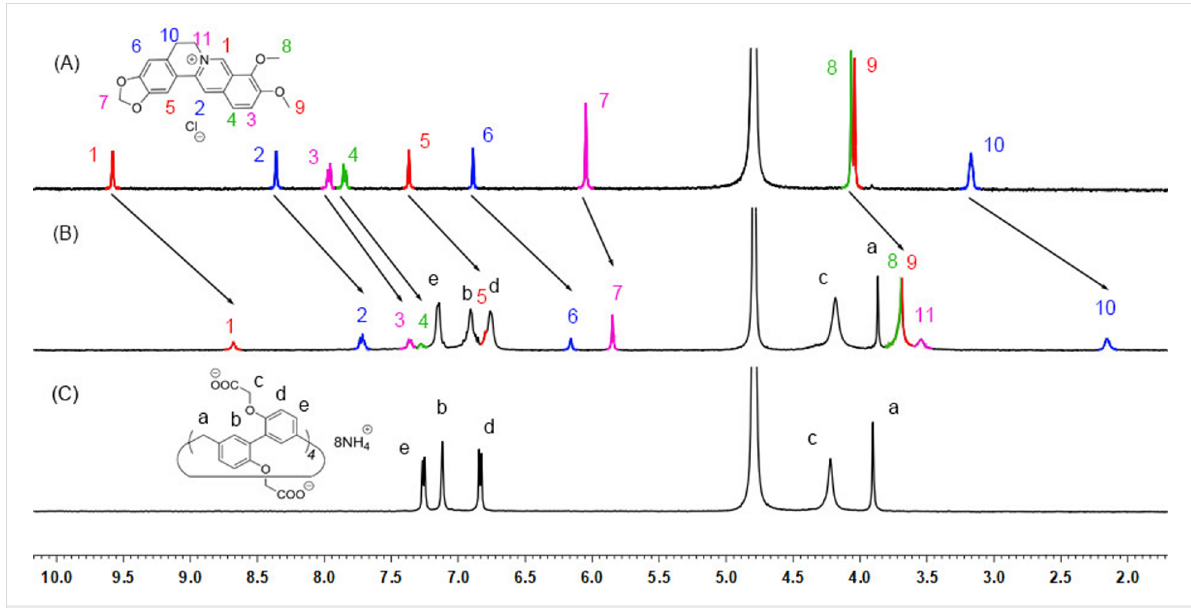
Figure 1: 1 H NMR spectra (500 MHz, 293 K) of (A) B (2.0 mM), (B) B (2.0 mM) + 2,2’-CBP4 (2.0 mM) and (C) 2,2’-CBP4 (2.0 mM) in deuterated phosphate buffer (pD